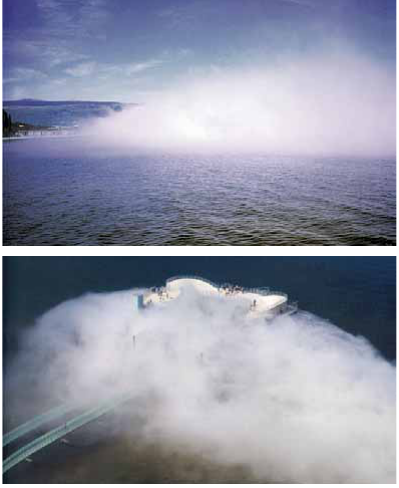
Fig 13. Diller + Scofidio . Blur